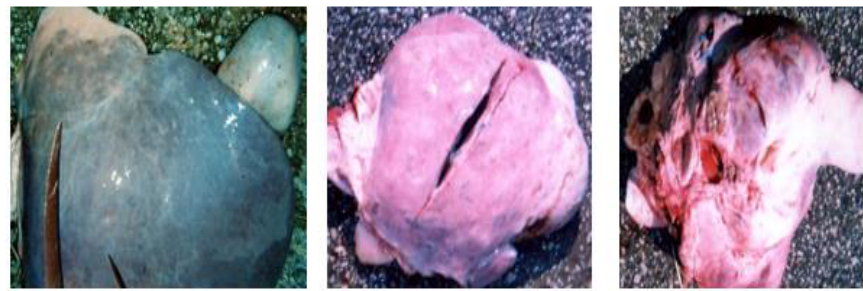
Figure 8. Hepatic Figure 8. Hepatic lesions.